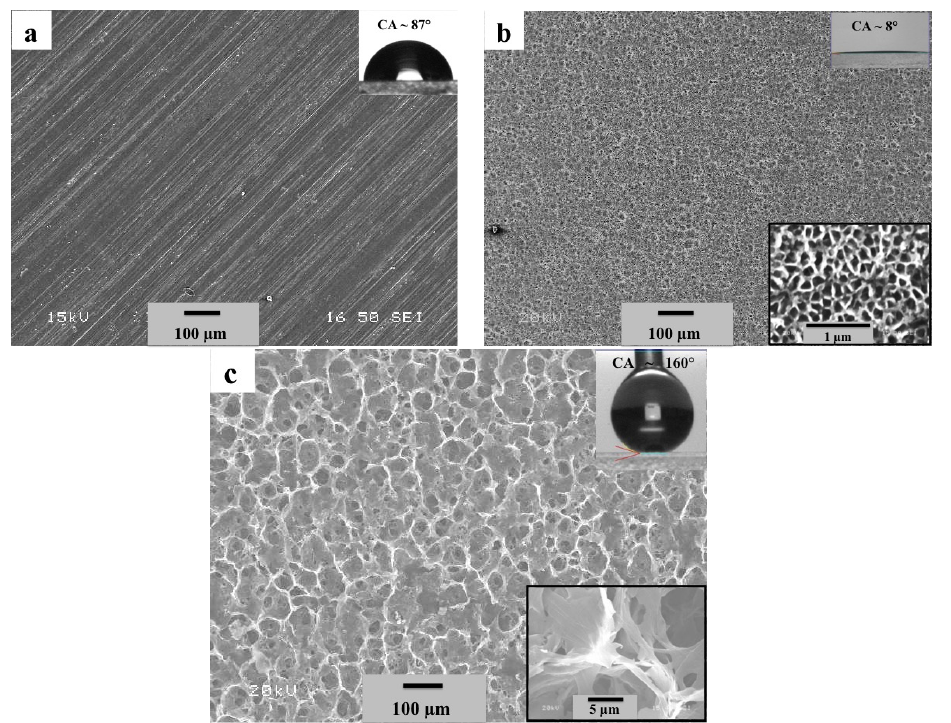
Figure 1. Secondary electron SEM micrographs showing the top surface of ( a ) the as-received aluminum alloy; ( b ) the anodized and ( c ) the electrodeposited anodized substrates. The inset top-right images present the water drop on the surfaces, and the bottom-right ones show magnified microstructures.